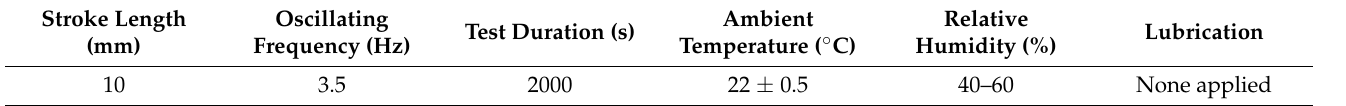
Table 3. Conditions of the wear tests.